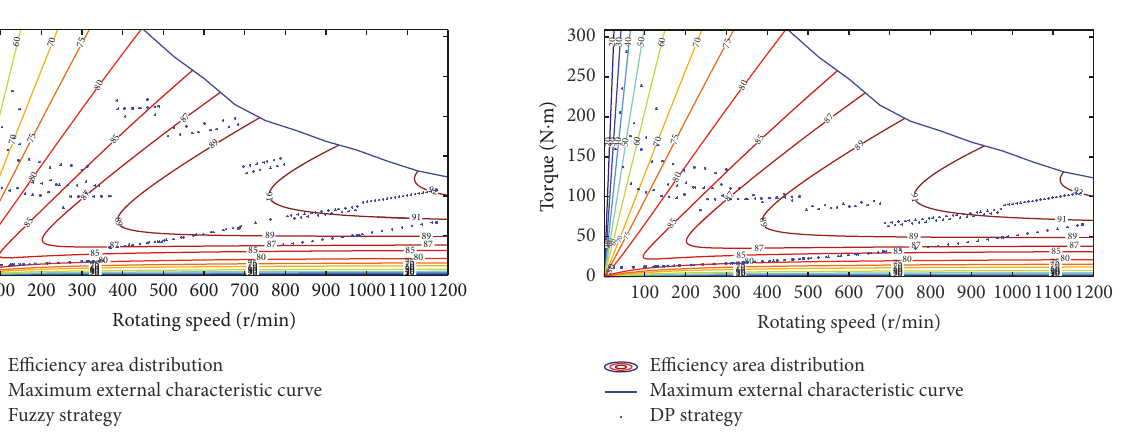
Figure 15: Distribution of motor working points under NEDC road condition.